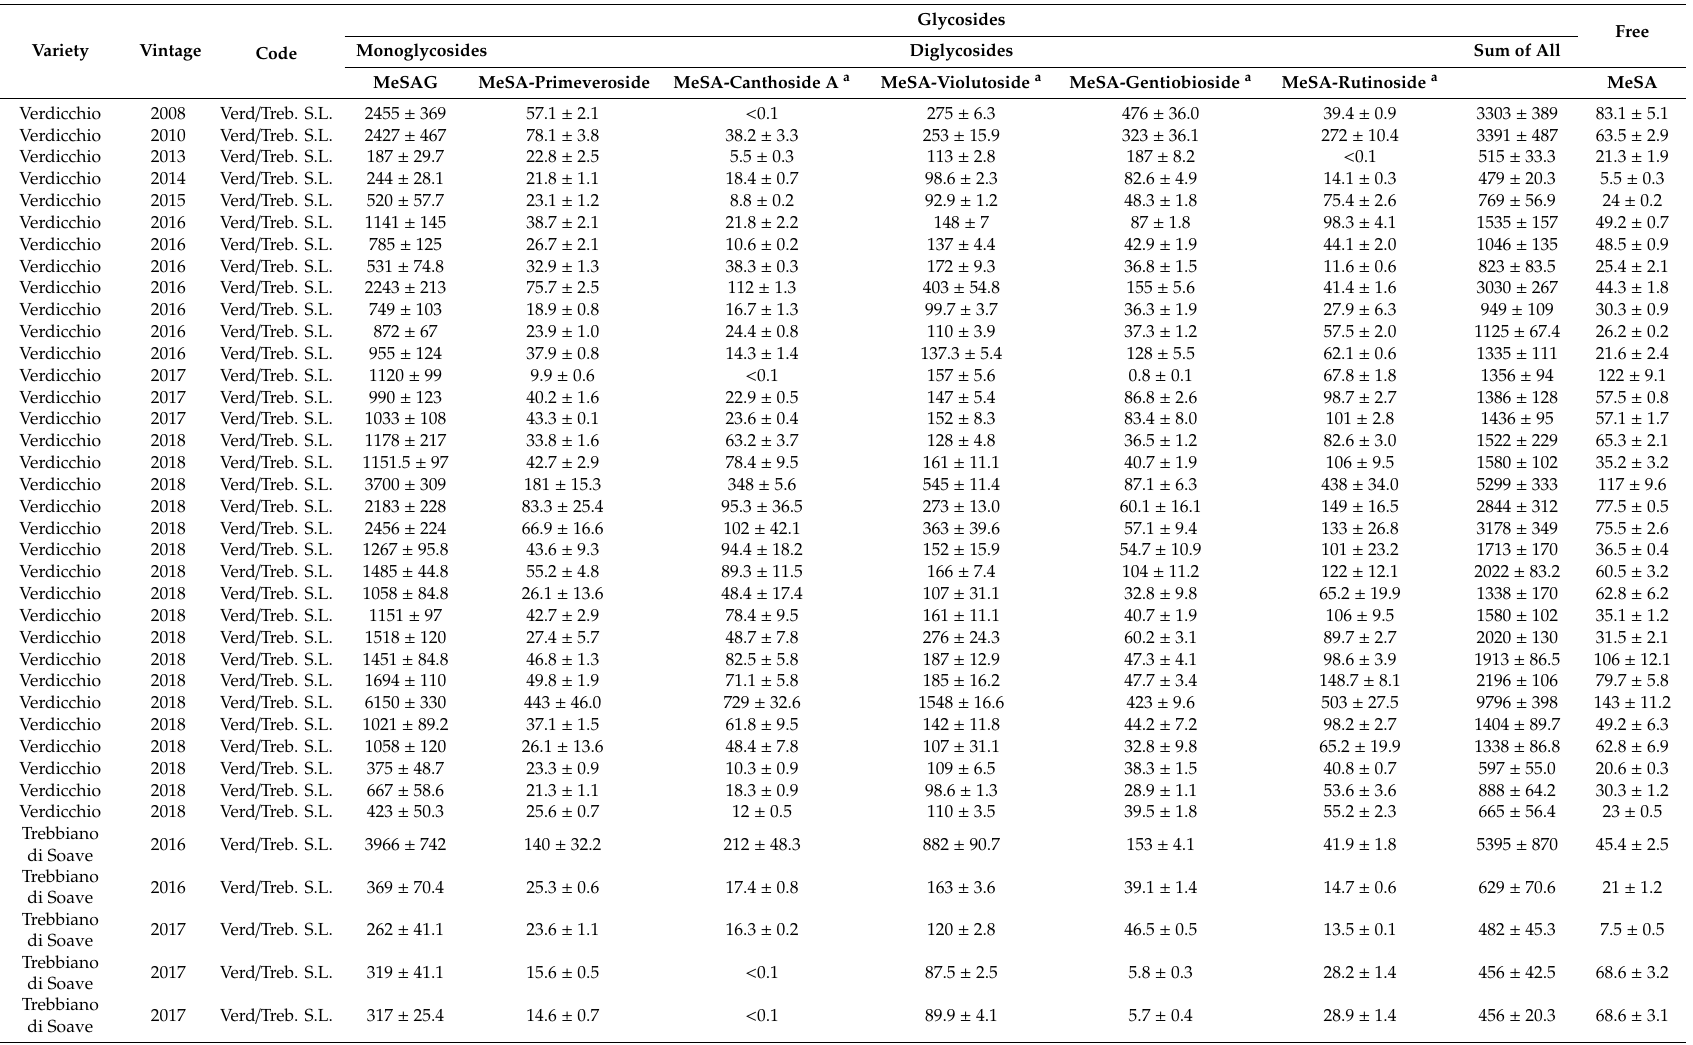
Table 2. Concentration (means ± standard deviation) of di ff erent MeSA glycosides and free MeSA in di ff erent wine varieties.